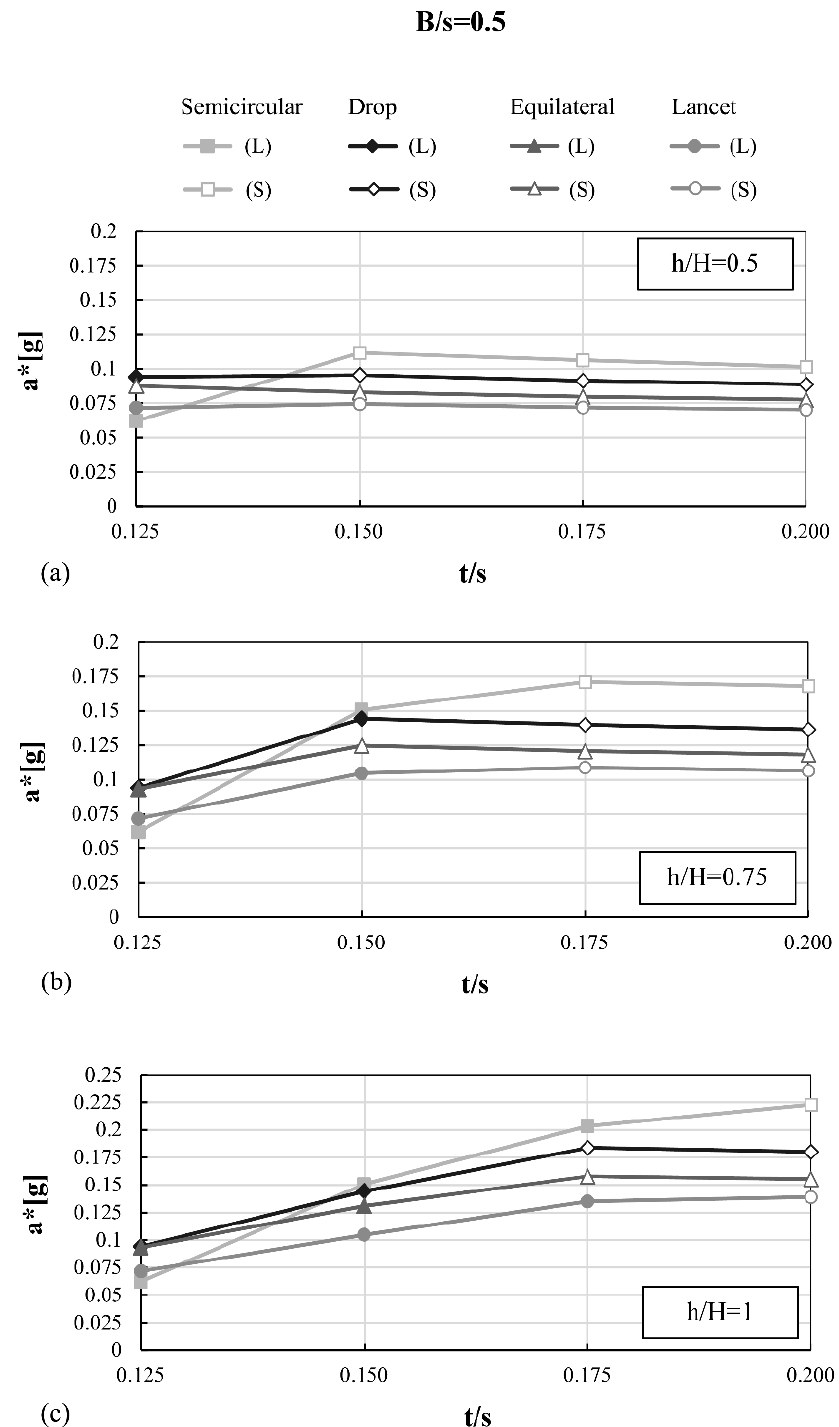
Figure 13. Values of a* for each considered eccentricity, each h/H configuration and B/s = 0.5, expressed with respect to the t/s ratio: ( a ) h/H = 0.5, ( b ) h/H = 0.75 and ( c ) h/H = 1.0. Local mechanism (L) or semi-global mechanism (S) are highlighted.